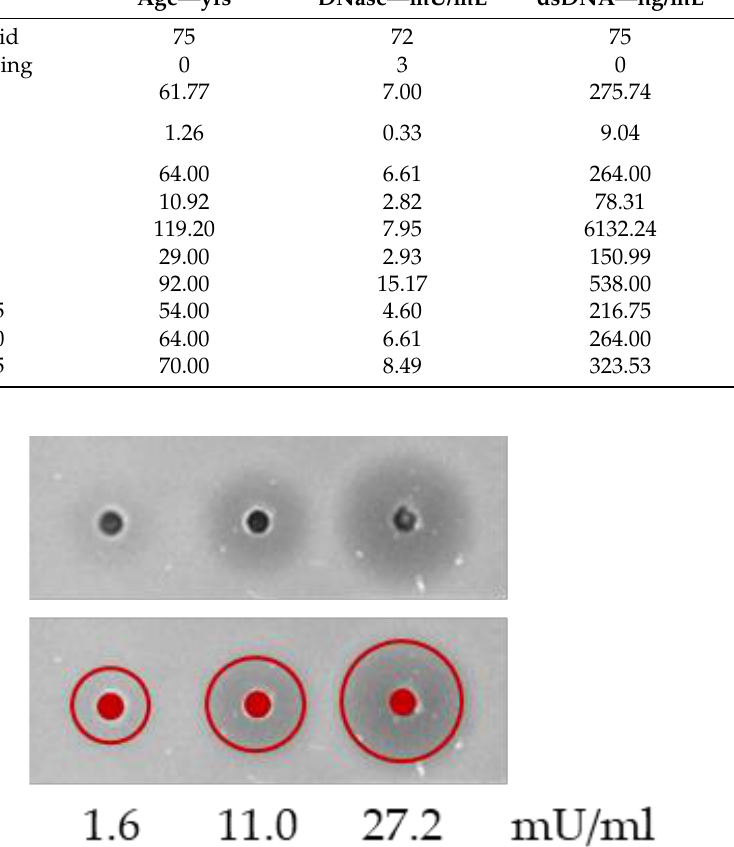
Figure A1. Single radial enzyme diffusion ( SRED) assays were analyzed using ImageJ. Per sample, a degradation index was calculated based on circumference (big red circle) and background-corrected intensity of the digested area, excluding the well (filled small circle). Representative SRED assays of three different samples with low, intermediate, and high DNase activity [mU/mL] are shown.